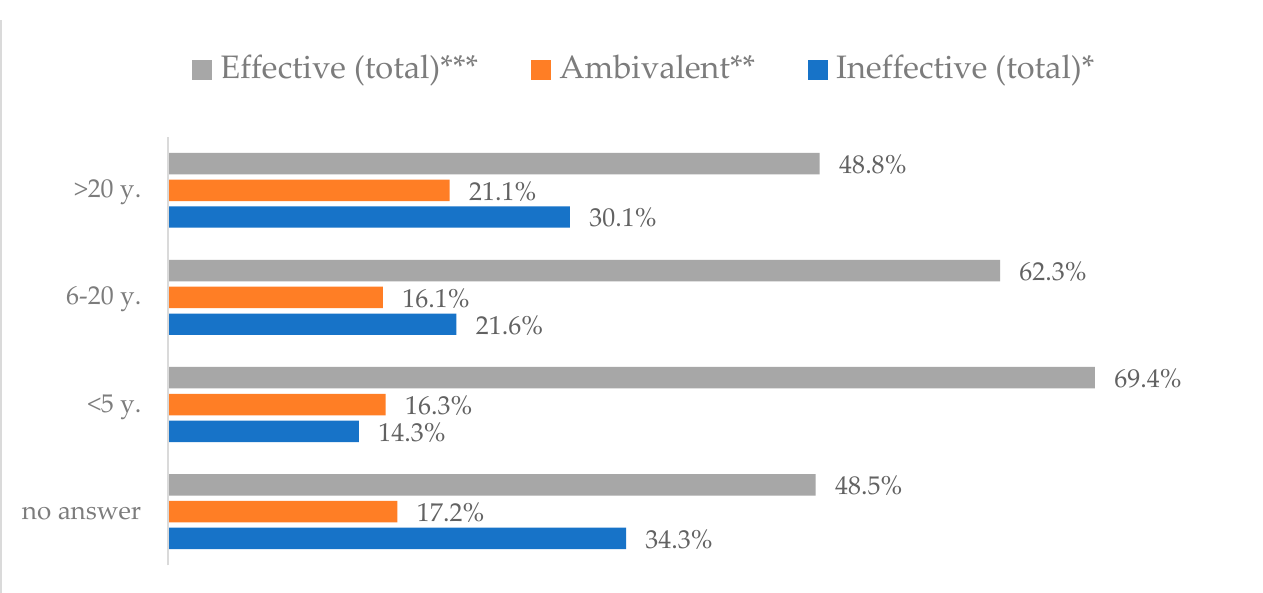
nor effective; ***Sum of responses: rather effective, effective, completely effective.